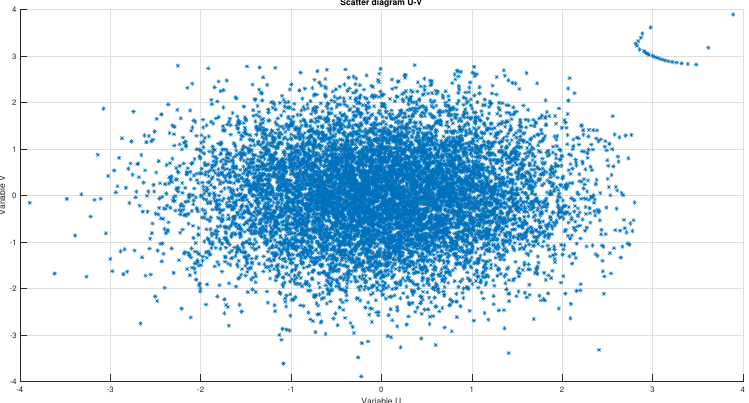
Figure 11. Scatter diagram U–V for the Ikeda map for distance d = 100.